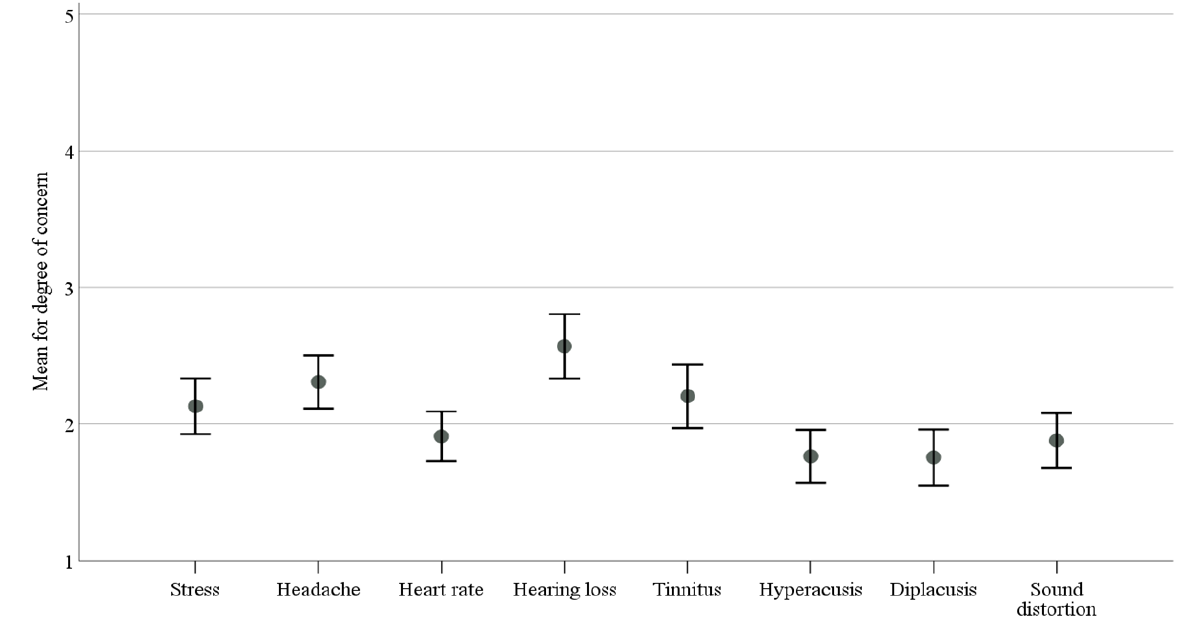
Figure 3. Degree of concern with health effects. Table 4. Percent of respondents expressing the level of concern with health effects among marching band members.